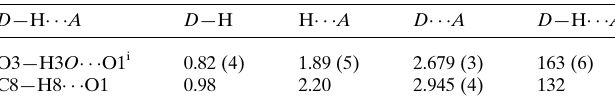
Table 1 Hydrogen-bond geometry (A˚ , (cid:2) ). D —H (cid:3)(cid:3)(cid:3) A